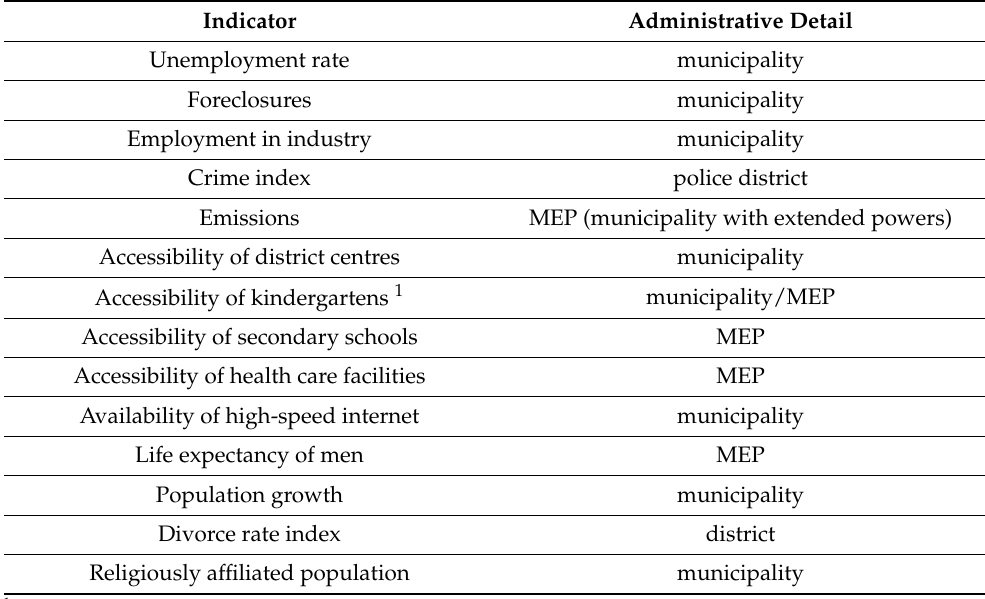
Table 1. Overview of quality of life indicators (original Median and Aspen Institute